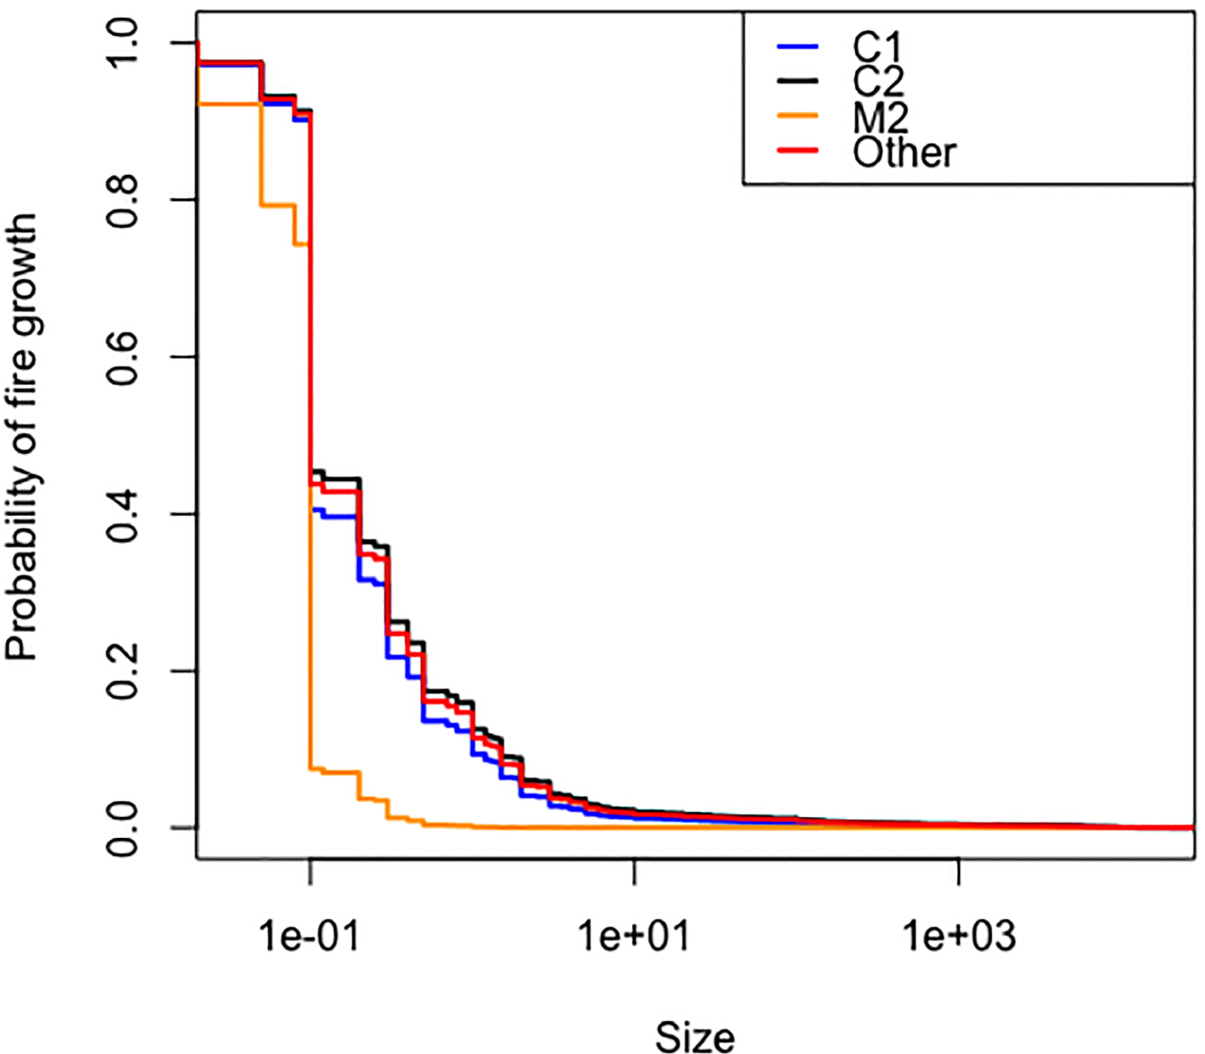
Fig 6. Cox proportional hazard model fitted survival curves for all levels of fuel type under air attack and median FWI. Levels of Fuel Type are represented by C1 (blue line), C2 (black line), M2 (orange line) and Other fuel type (red